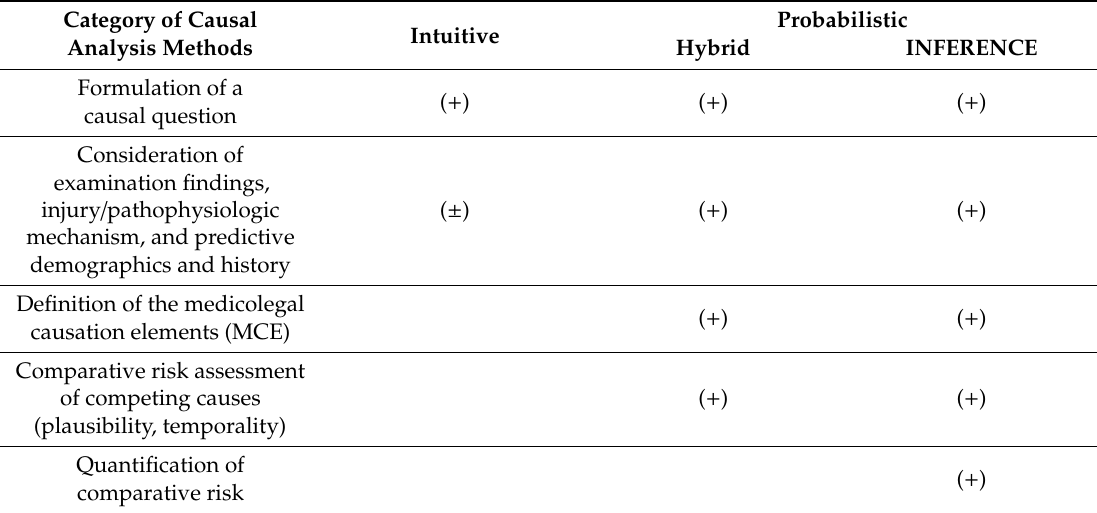
Table 1. Elements of causal analysis